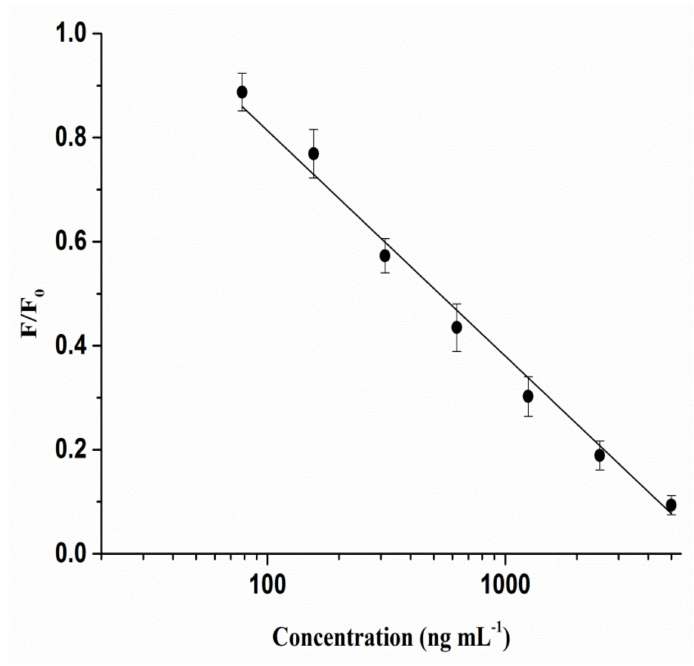
Figure 4. The calibration curve of QBs-FLISA for glycinin.